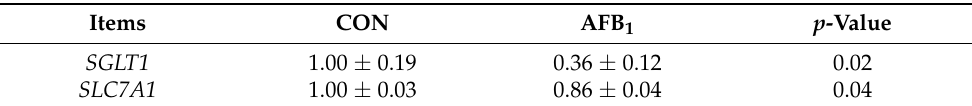
Table 7. Effects of AFB 1 on the relative mRNA expressions of nutrient transporters in jejunal mucosa of pigs.